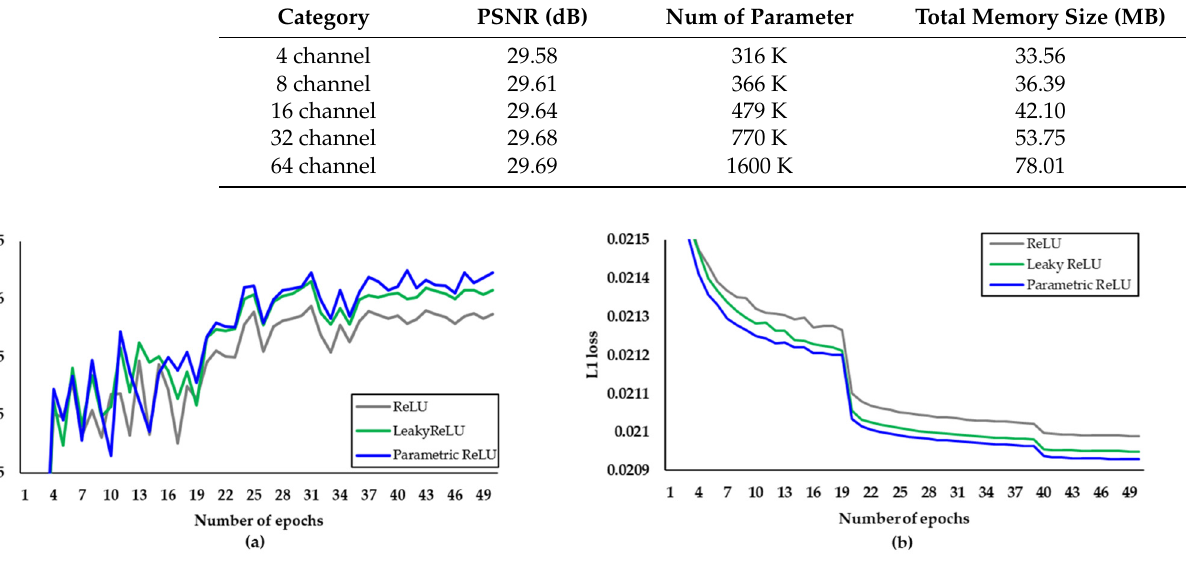
Figure 4. Verification of activation functions. ( a ) PSNR per epoch. ( b ) L1 loss per epoch. Table 4. Verification tests for loss functions.